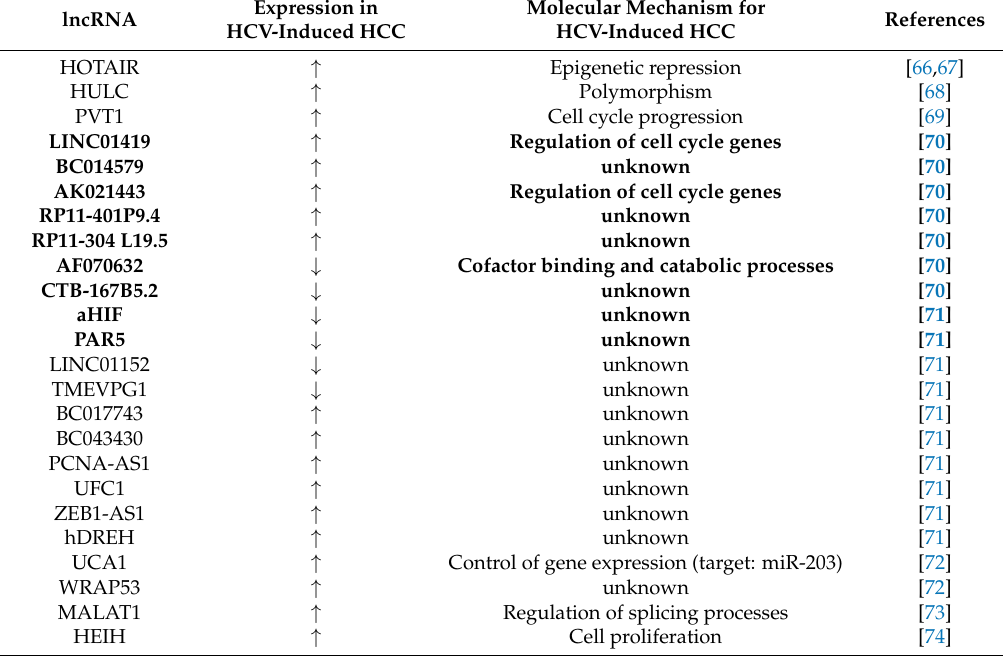
Table 1. Role of lncRNAs in HCV-induced HCC. The expression of lncRNAs that have been associated with HCV-induced HCC, as well as their biological function, are shown. lncRNAs that have been reported to be uniquely modulated in HCC induced by HCV, but not in HCC induced by another etiological factor, are highlighted in